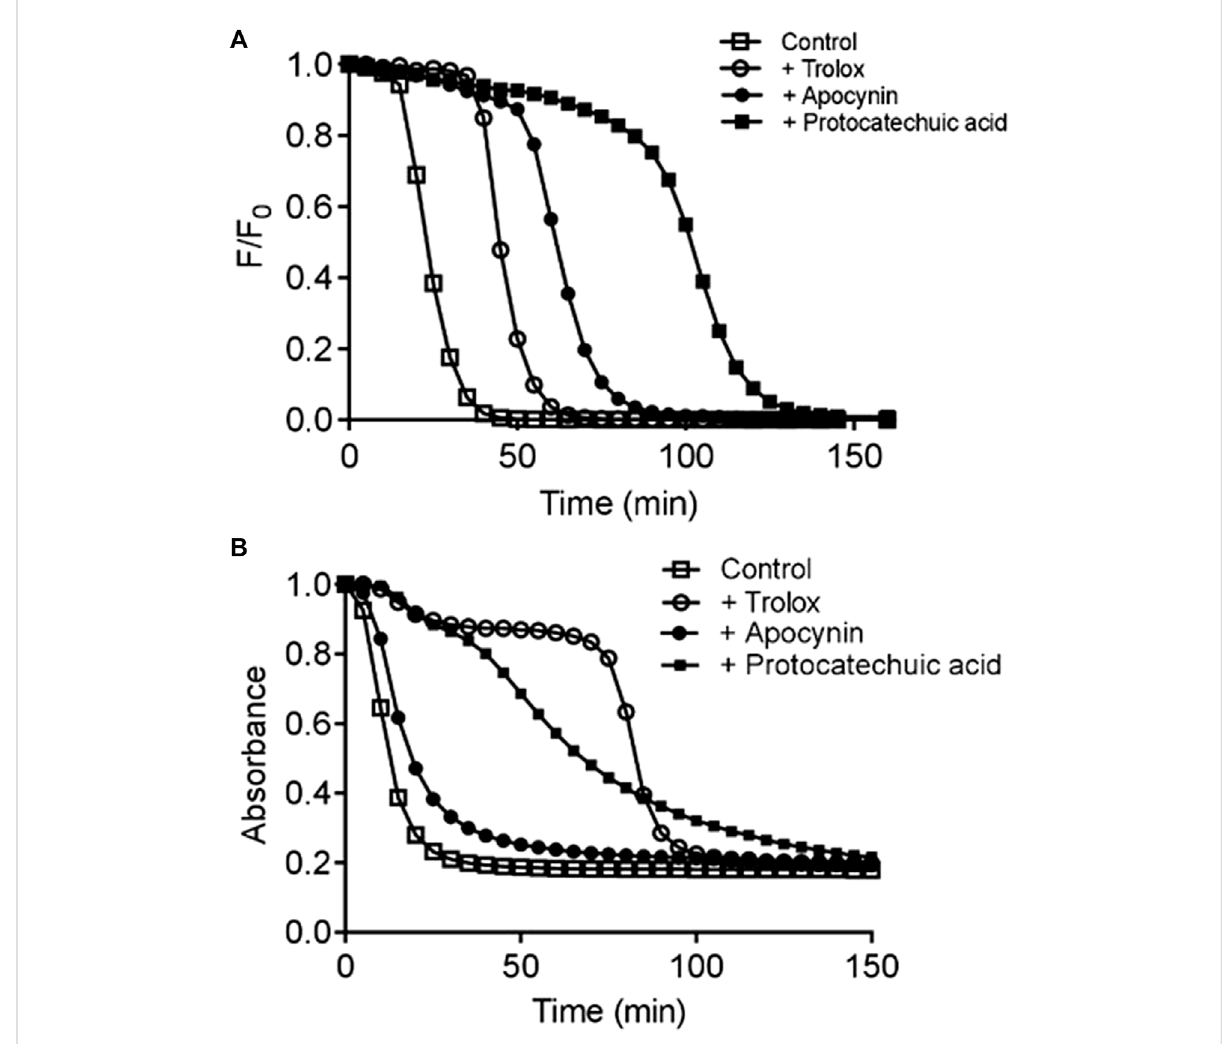
FIGURE 3 Evaluation of direct free radical scavenging capacity. Kinetic pro fi le of fl uorescein degradation by ROO compounds determined by oxygen radical absorbance capacity (ORAC) assay (A) . Kinetic pro fi le of triene degradation provoked by AAPH and the protectiveeffectofthestudiedcompoundsdeterminedbyconjugatedautoxidizibletriene(CAT)assay (B) . a Troloxequivalent(µmolsofTrolox/µmol of studied compound). b EC 50 (µmol/L). The results are mean and SD of three experiments. # p < 0.05 Protocatechuic acid vs.